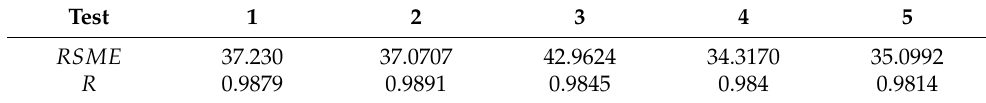
Table 5. Results of Five Validations for the Throughput RSM Meta-Model.